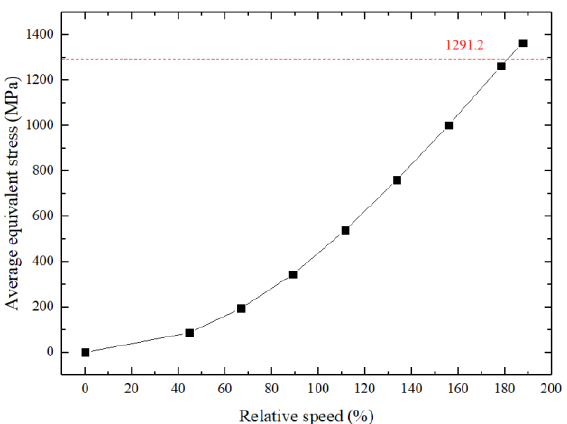
Figure 25. The variation of average equivalent stress of the dangerous section of the vortex reducer with rotational speed.